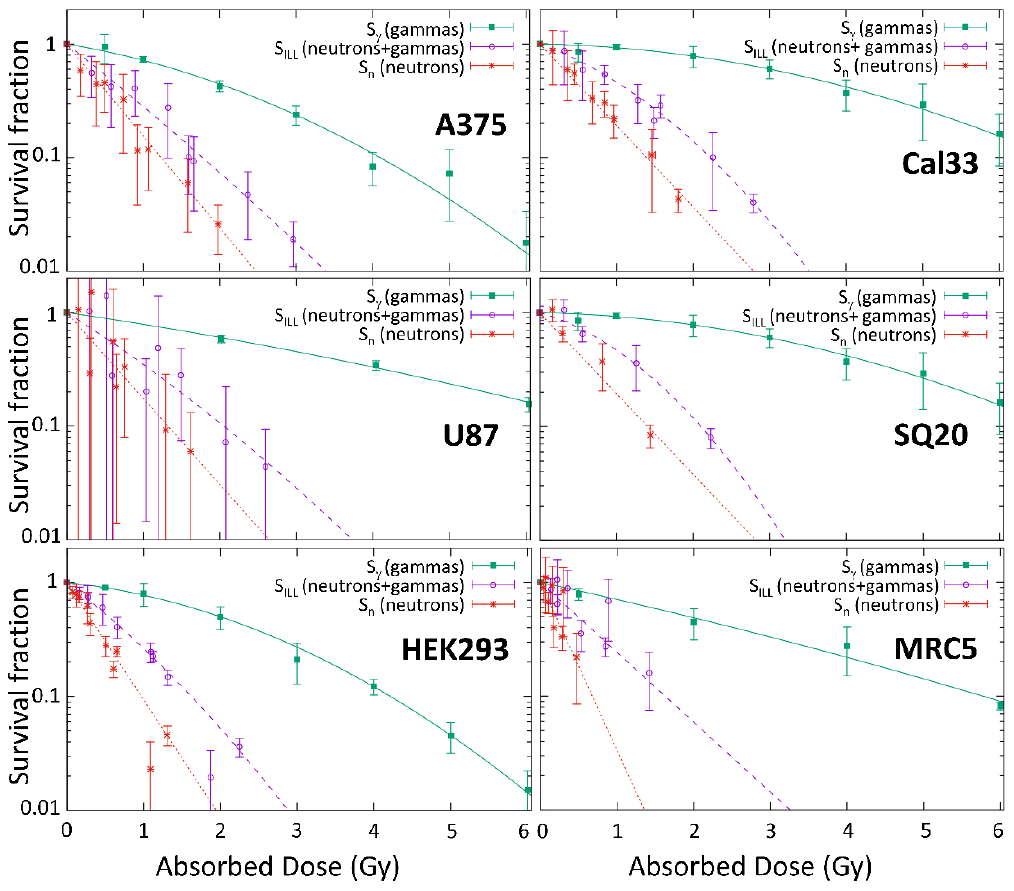
Figure 6. Clonogenic survival of six cell lines as a function of the absorbed dose (Gy) following irradiation with photons at the medical linear accelerator, S γ , with neutrons at the ILL beam, S ILL , and, derived, ILL neutrons alone, S n . S γ for U87 from [27] and S γ for SQ20 from the one obtained for Cal33. The data were obtained from between two and seven individual experiments after photon and neutron irradiation. Cells were seeded in triplicate for each data point in each experiment. Table 2. Alpha and beta values ( ± standard error) for medical linear accelerator irradiations and for the di ff erent dose components at ILL.